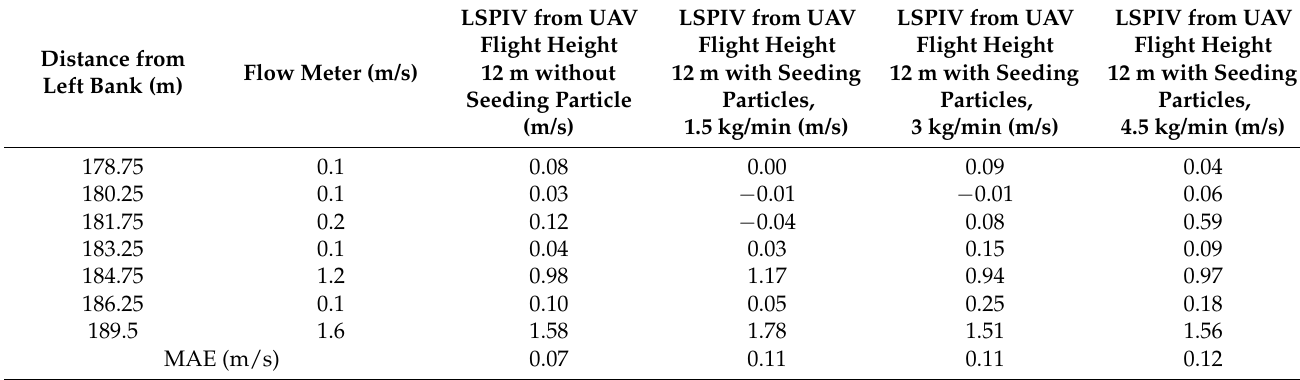
Figure 8. Comparison of measured surface velocities obtained using LSPIV derived from UAV flight height of 12 m without seeding particle, with different densities of seeding artificial particles, and a flow meter. Table 3. The statistical error and the measured surface velocity using LSPIV from UAV flight height of 12 m without and with artificial seeding